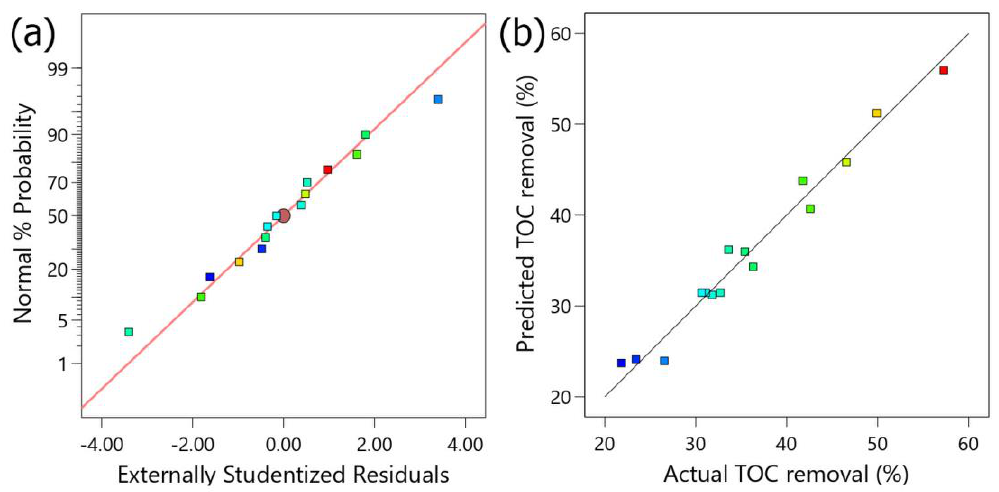
Figure 2. ( a ) Normal probability plot and ( b ) RSM predicted vs. actual values for TOC removal.